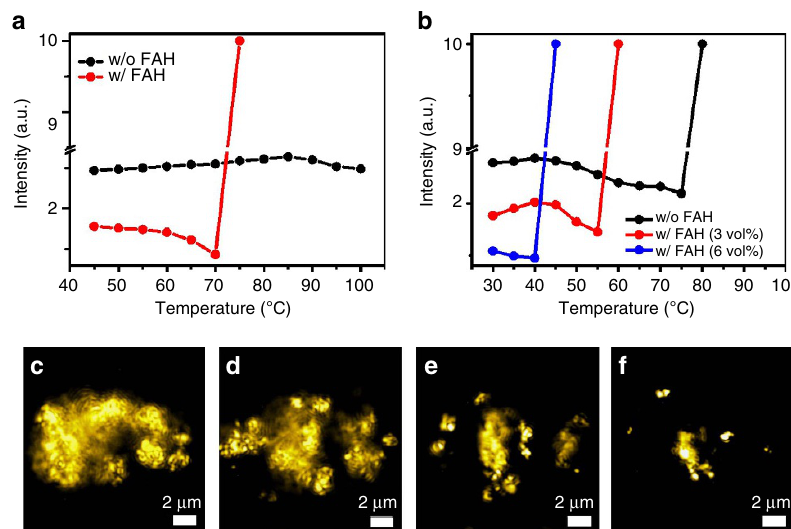
Figure 3 | Colloid dissolution effect. ( a ) Effect of added acid and temperature on the scattered light intensity of CH 3 NH 3 Cl þ PbCl 2 in DMSO. ( b ) Effect of added acid and temperature on scattered light intensity of CH 3 NH 3 Br þ PbBr 2 in DMF. In both the graphs, the value of 10 (a.u.) represents the saturation point of the detector. ( c – f ) Micrographs from iSCAT imaging of dissolution of colloids after addition of FAH (10 vol%) in the 1M CH 3 NH 3 I þ PbI 2 in GBL at room temperature (see Supplementary Movie